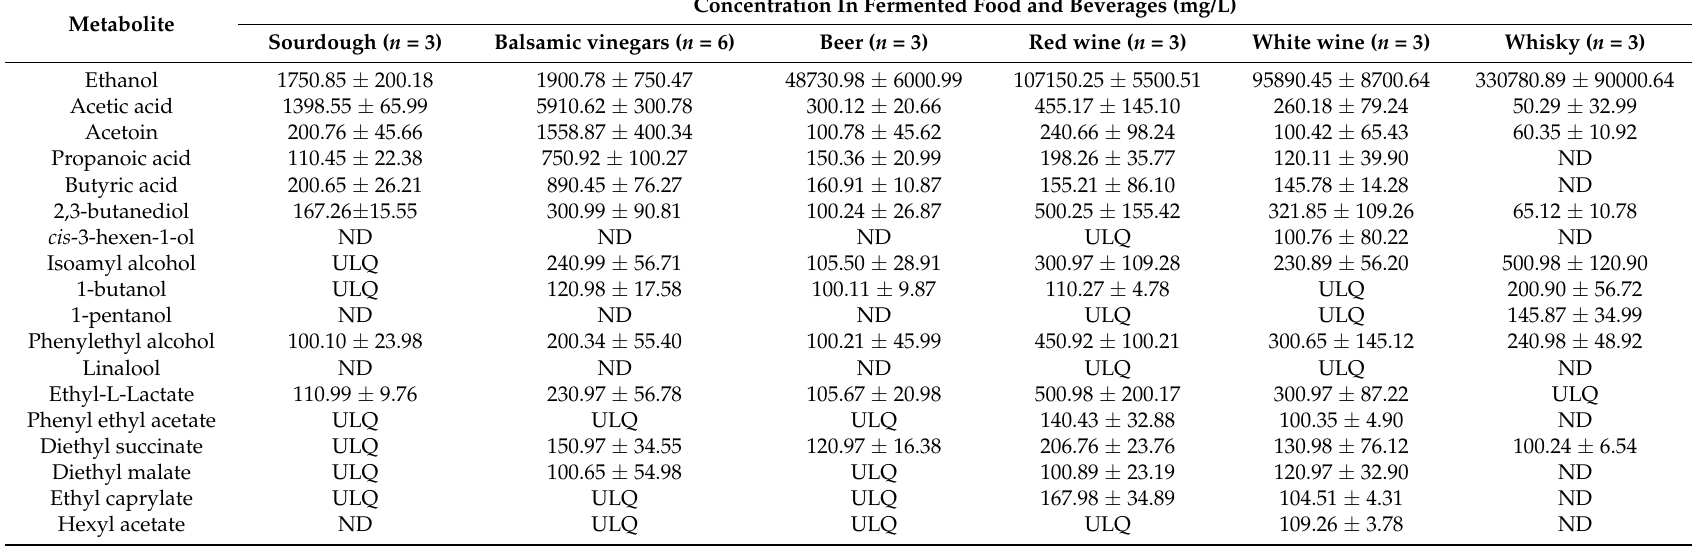
Table 4. Concentration of major volatile metabolites present in different fermented food and